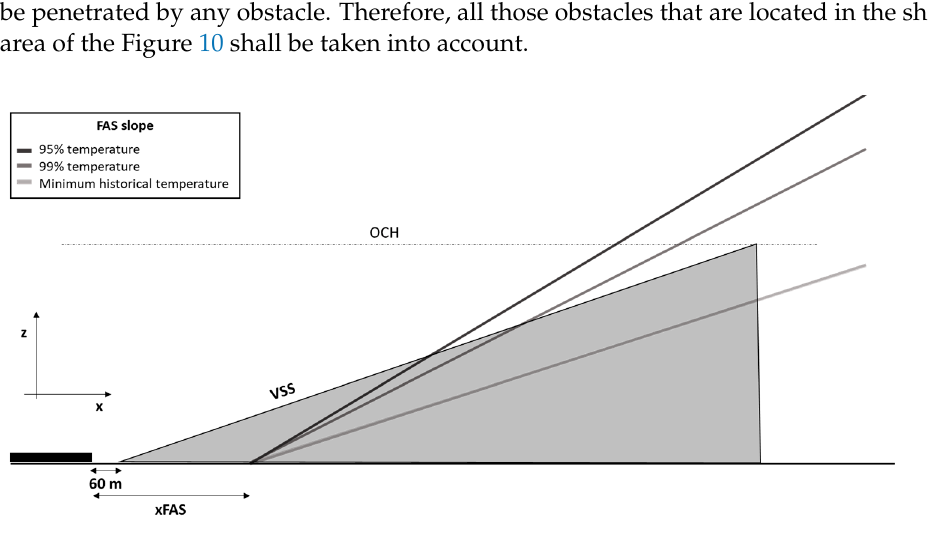
Figure 10. VSS and FAS surfaces.